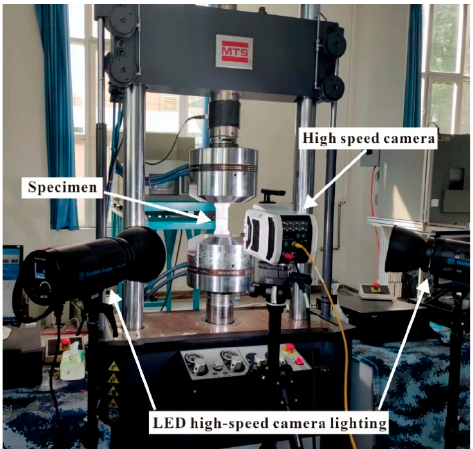
Figure 7. High-speed camera shooting test piece and supporting LED camera lighting equipment.